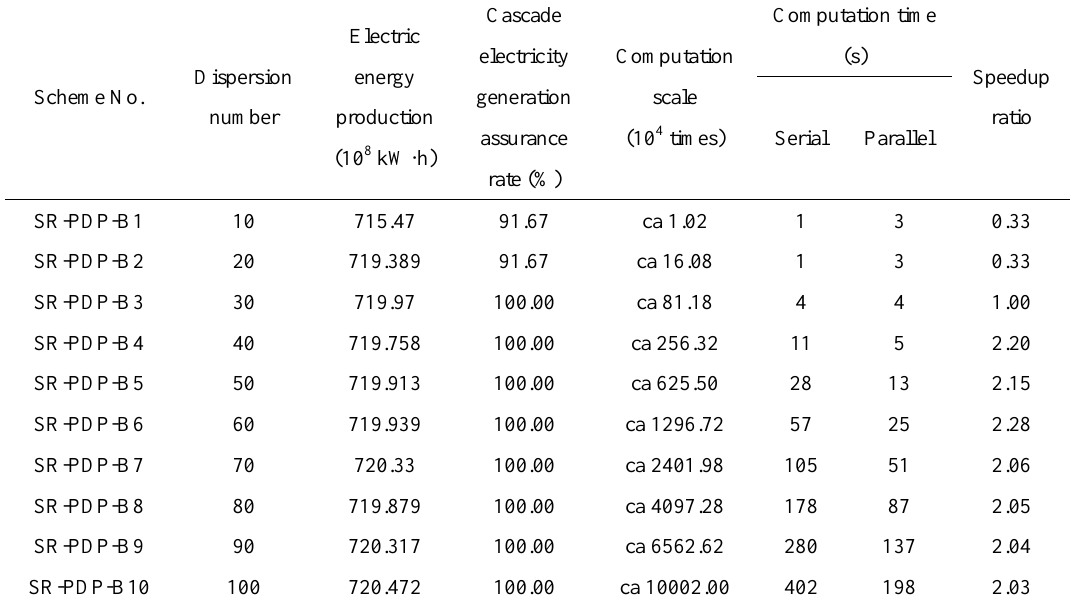
Table 2 Comparison of analog computation results of different dispersion schemes